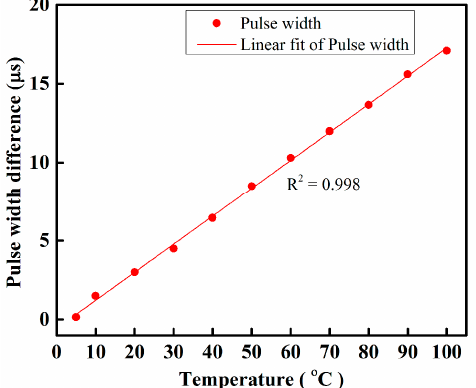
Figure 8. Behavior of the proposed fiber-optic PWM temperature sensing system under different temperatures.